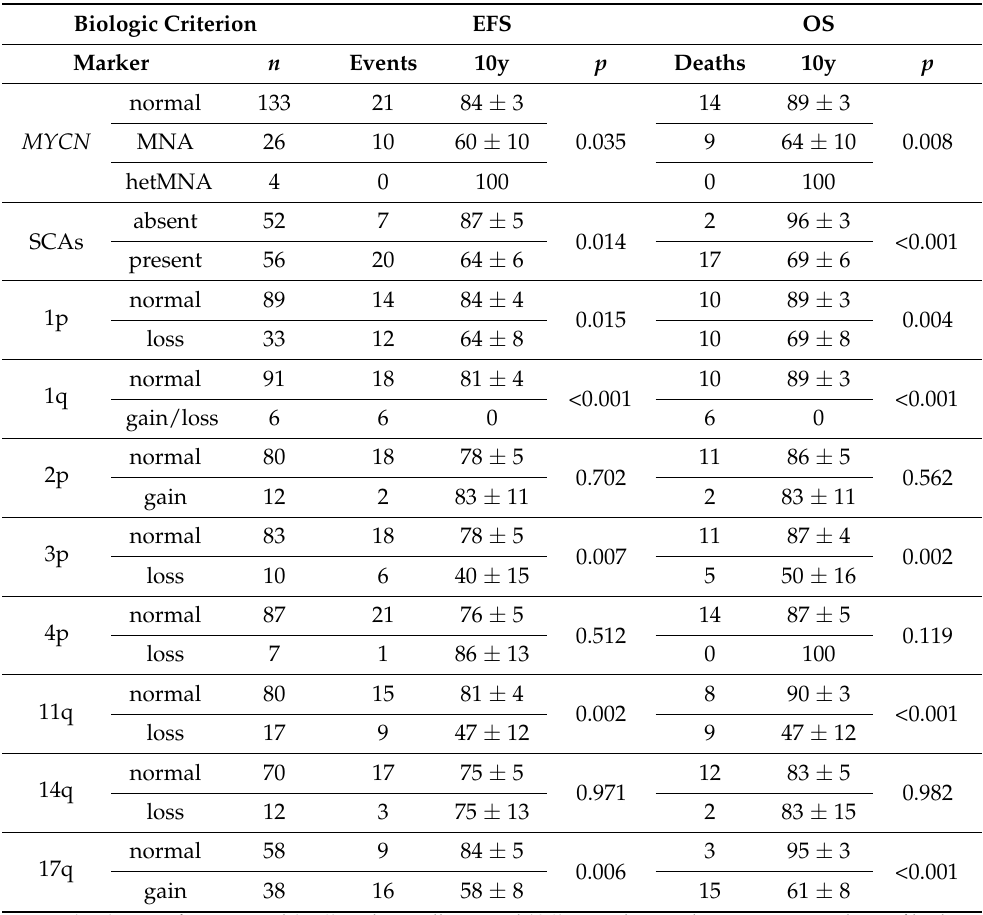
Table 3. Summary of 10-year outcomes with reference to biologic markers.